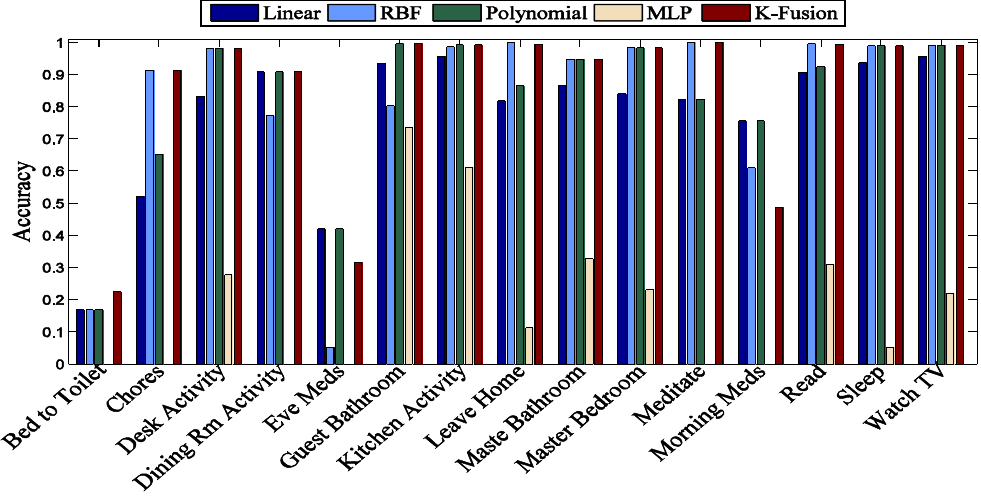
Figure 4. Individual class accuracy of different kernel functions for Milan2009.